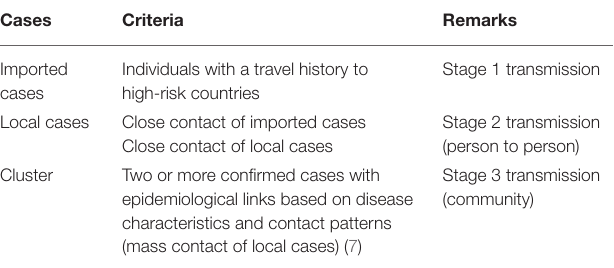
TABLE 2 | Terminology used to define the mode of transmission in this observation.